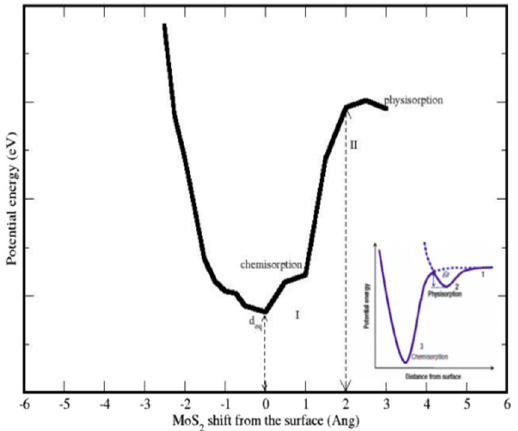
Figure 8. Nature of adsorption of MoS 2 on the surface of STO (001); MoS 2 monolayer is shifted in units of Å. d eq is taken as 0 shift and further shifts are added to d eq ; figure in inset shows the ideal adsorption curve shows the trend of chemisorption and physisorption 53 .